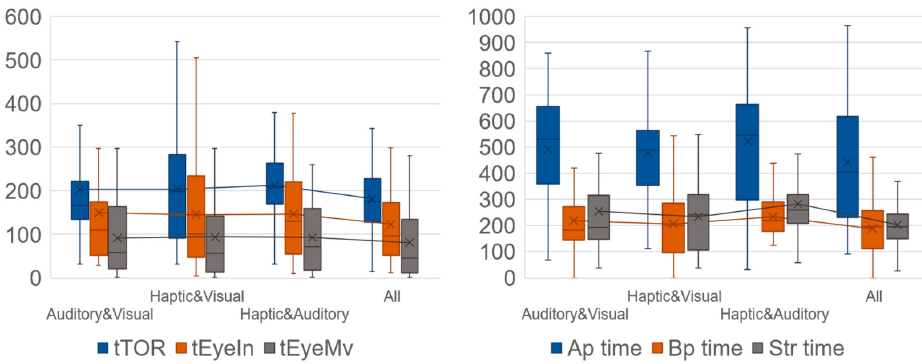
Figure 13. Driver reactions of multimodality TOR ( 𝑛 (cid:3002)&(cid:3023) = 89,𝑛 (cid:3009)&(cid:3023) = 62,𝑛 (cid:3009)&(cid:3002) = 87,𝑛 (cid:3028)(cid:3039)(cid:3039) = 139 ).